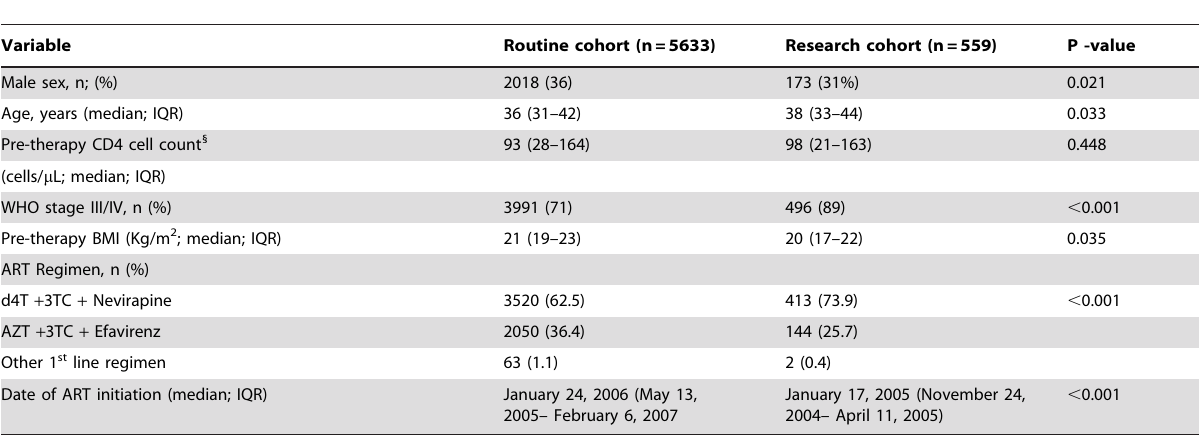
Table 1. Baseline characteristics for Routine and Research